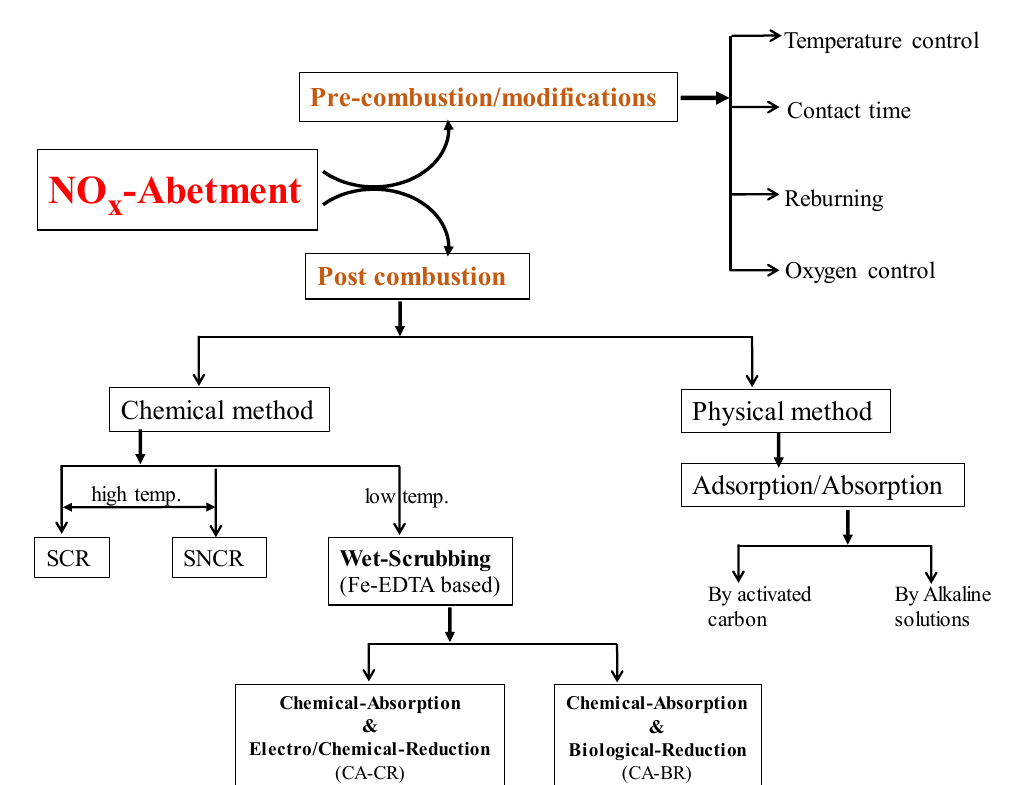
Figure 2. General overview of NO x abatement systems by pre combustion and post combustion techniques, which further divided into specific methods based on operations.